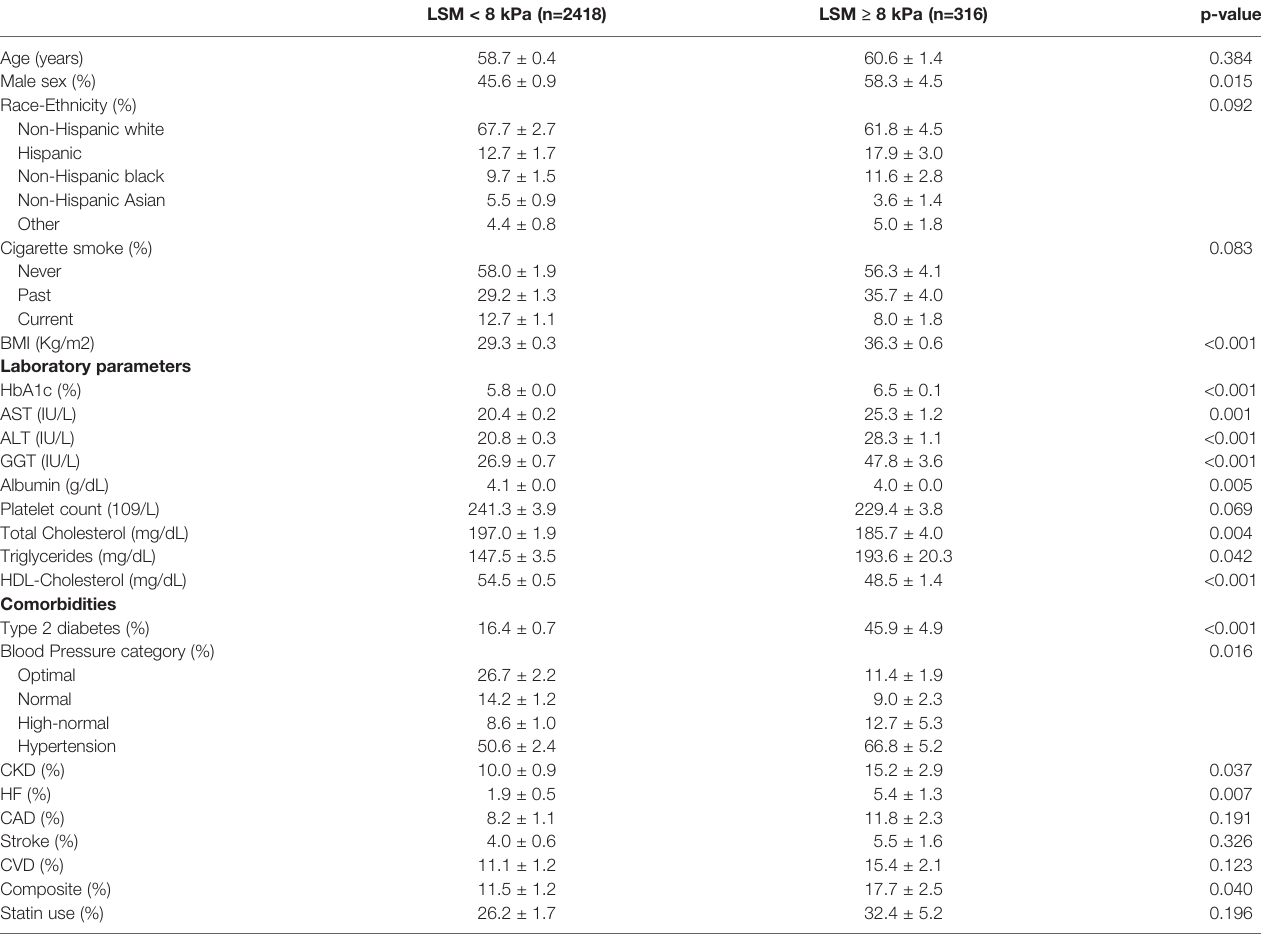
TABLE 2 | Features of the study population according to the presence of signi fi cant liver fi brosis assessed by the median liver stiffness measurement